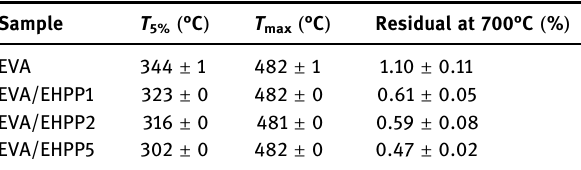
Table 2: Data of TG and DTG for EVA and its composites under nitrogen conditions Sample